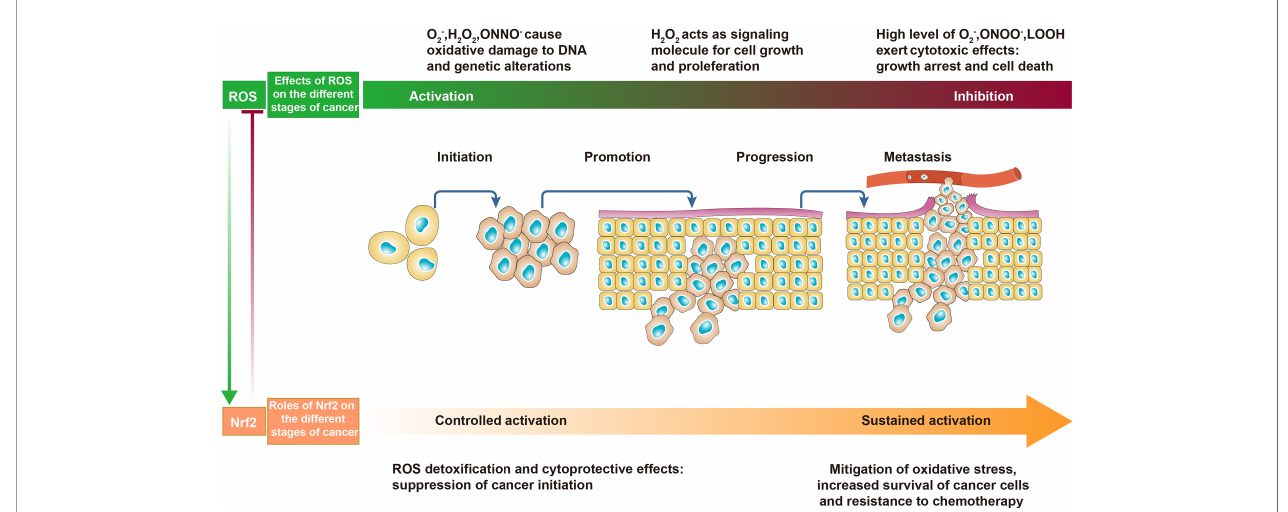
FIGURE 2 | The effects of reactive oxygen species (ROS) and Nrf2 on cancer. In the early stages of cancer, appropriate levels of ROS act as initiators and mediators of carcinogenesis and cancer promotion. In the advanced stages of cancer, excessive ROS promote cancer cell death and are detrimental to cancer progression. In normal cells and precancerous cells, controlled activation of Nrf2 decreases ROS and inhibits cancer initiation. In malignant and metastatic cells, sustained activation of Nrf2 counteracts oxidative stress to promote cancer